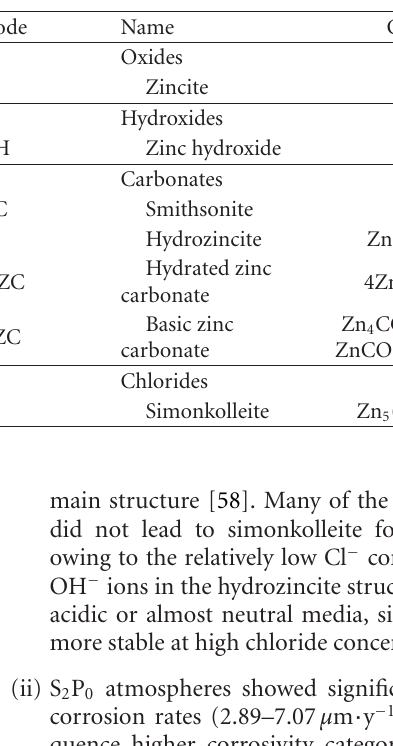
Table 7: Zinc corrosion products identified in the MICAT